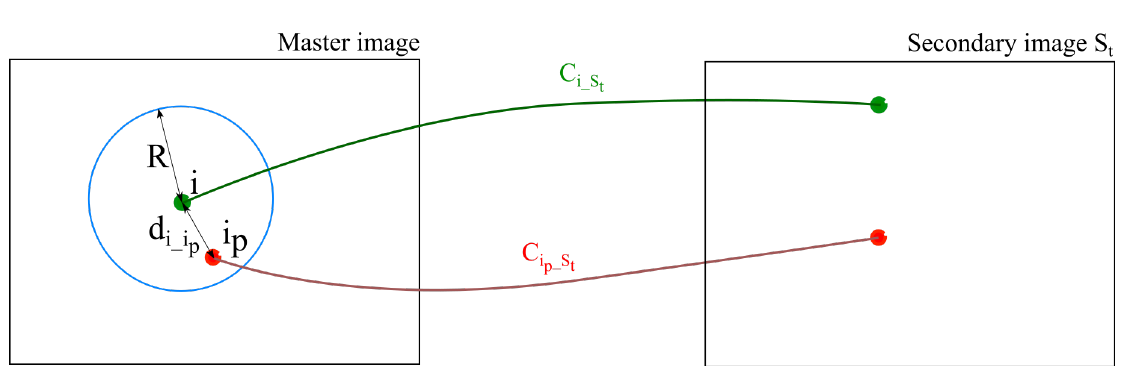
Figure 14. An illustration for terms in Equation (8). C i _ S master image and its matched point on secondary image S t .